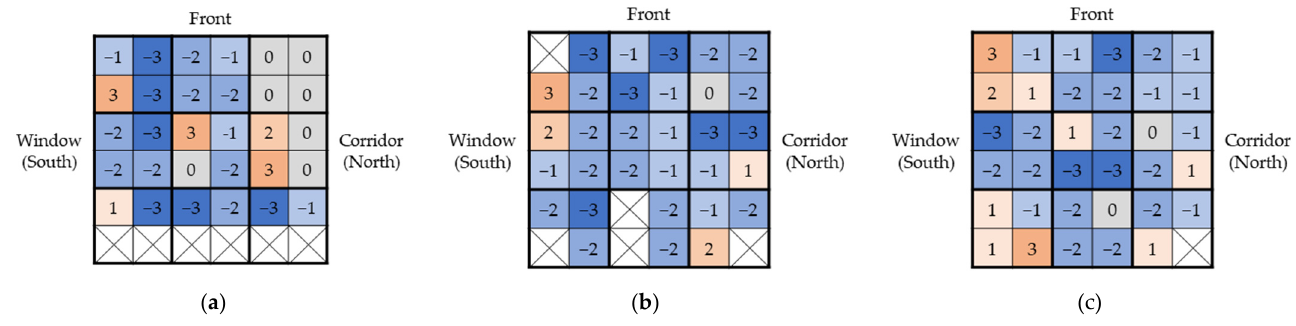
( c ) Figure 27. Summer average air temperature in ( a ) class A, ( b ) class B, and ( c ) class C.